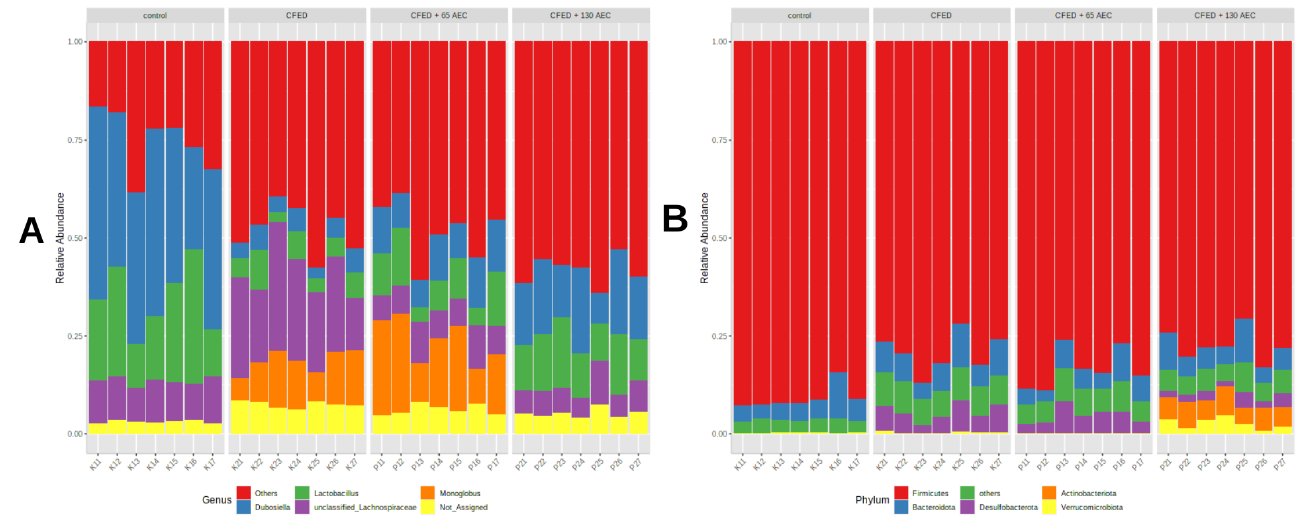
Figure 3. Taxonomic composition at the genus level ( A ) or phylum level ( B ). Each colored bar represents the percentage of each phylum or genus relative to the total microorganisms. CFED: cholesterol- and fat-enriched diet.